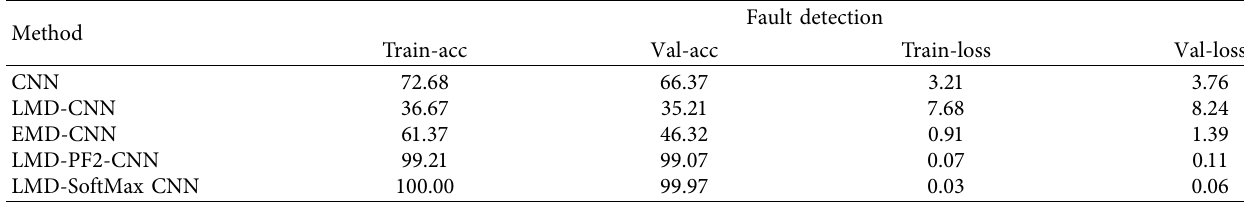
Figure 20: The structure and principle of the confusion matrix. Table 5: The accuracy and loss rate of 1-D CNN.